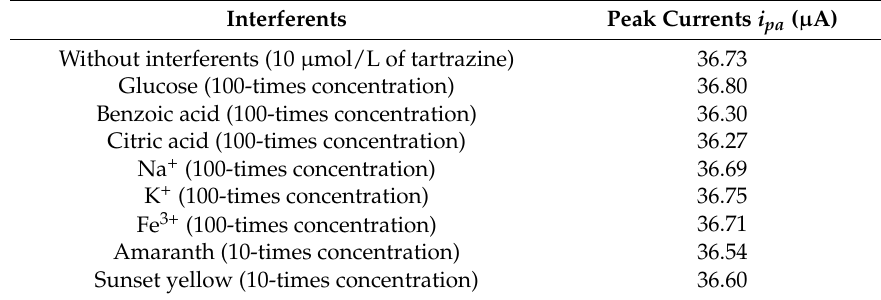
Table 1. The influence of different interferents on the detection ability of tartrazine by TiO 2 –ErGO–GCE. Interferents Peak Currents i pa (μA)